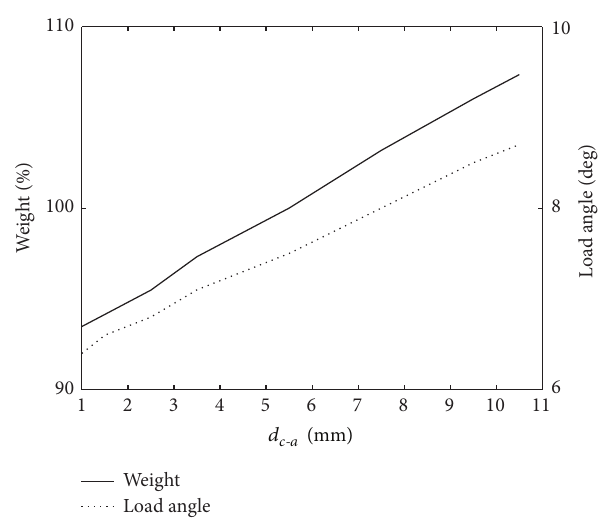
Figure 5: The change in weight and the load angle as a function of the distance from the winding to the air gap.